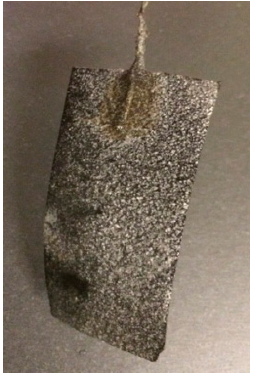
Figure 4. Evidence of phosphorus precipitation on the cathode.